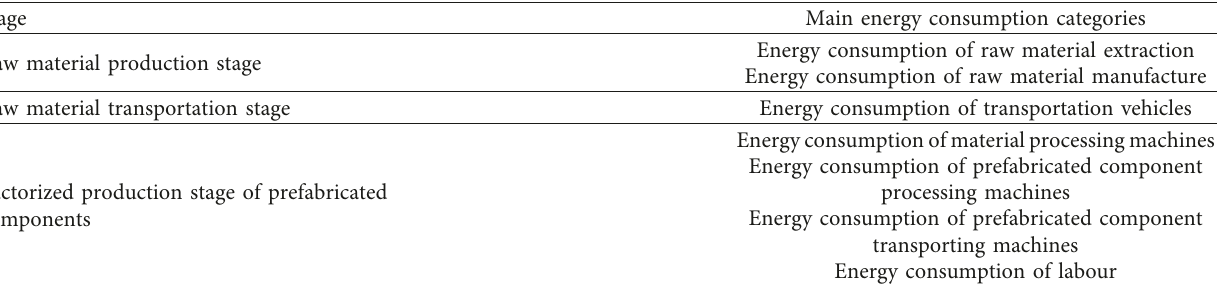
Table 1: Main energy consumption categories of prefabricated components production.